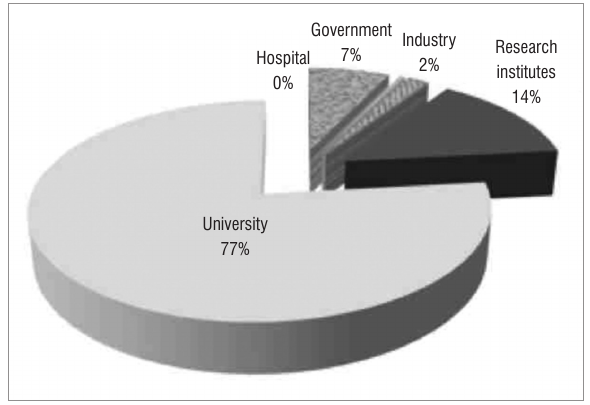
Figure 3: Sectoral share of authors in the natural sciences, 1975–2005. The third major sector was government, which is comprised of departments, parks, museums and gardens. In 1975, this sector had a mean number of authors of 0.48, which by 2005 had reduced to 0.03. was gradual until 1990, i.e. 65% in 1980, 29% in 1985, 31% in 1990